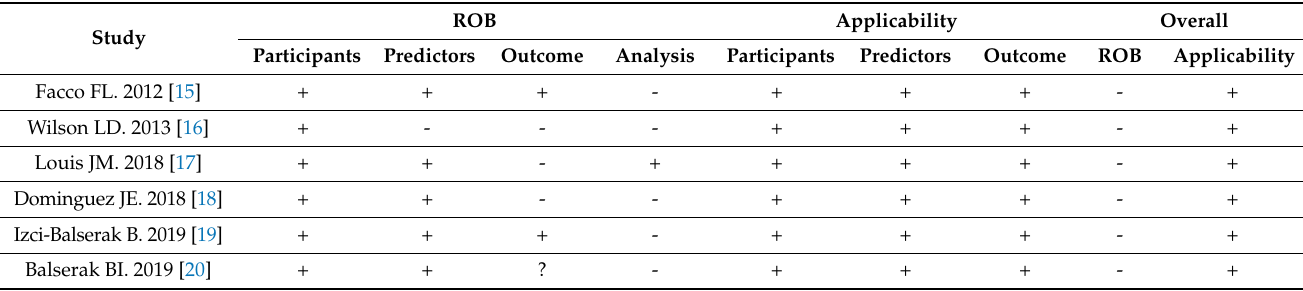
Table 3. Tabular Presentation for The Prediction model Risk of Bias Assessment Tool (PROBAST) Results of studies of gestational obstructive sleep apnea.